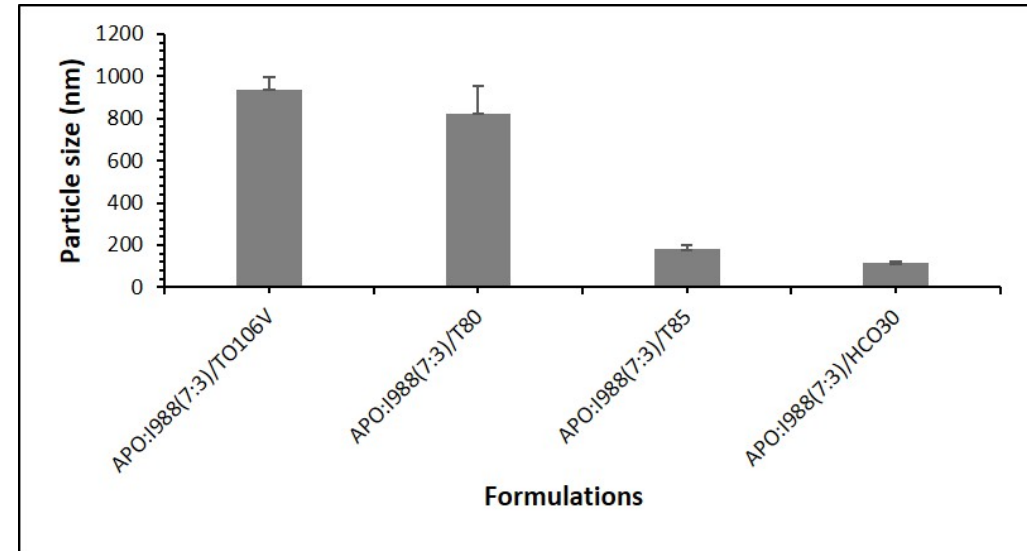
Figure 4. Effect of surfactants on the droplet size of the APG bioactive formulations. The excipients were mixed as % ( w / w ) at a fixed ratio. Bio-SNEDDSs were represented by APO/I988/TO106V (35/15/50)-F12, APO/I988/T80 (35/15/50)-F4, APO/I988/T85 (35/15/50)-F13, and APO/I988/HCO30 (35/15/50)-F6, respectively.